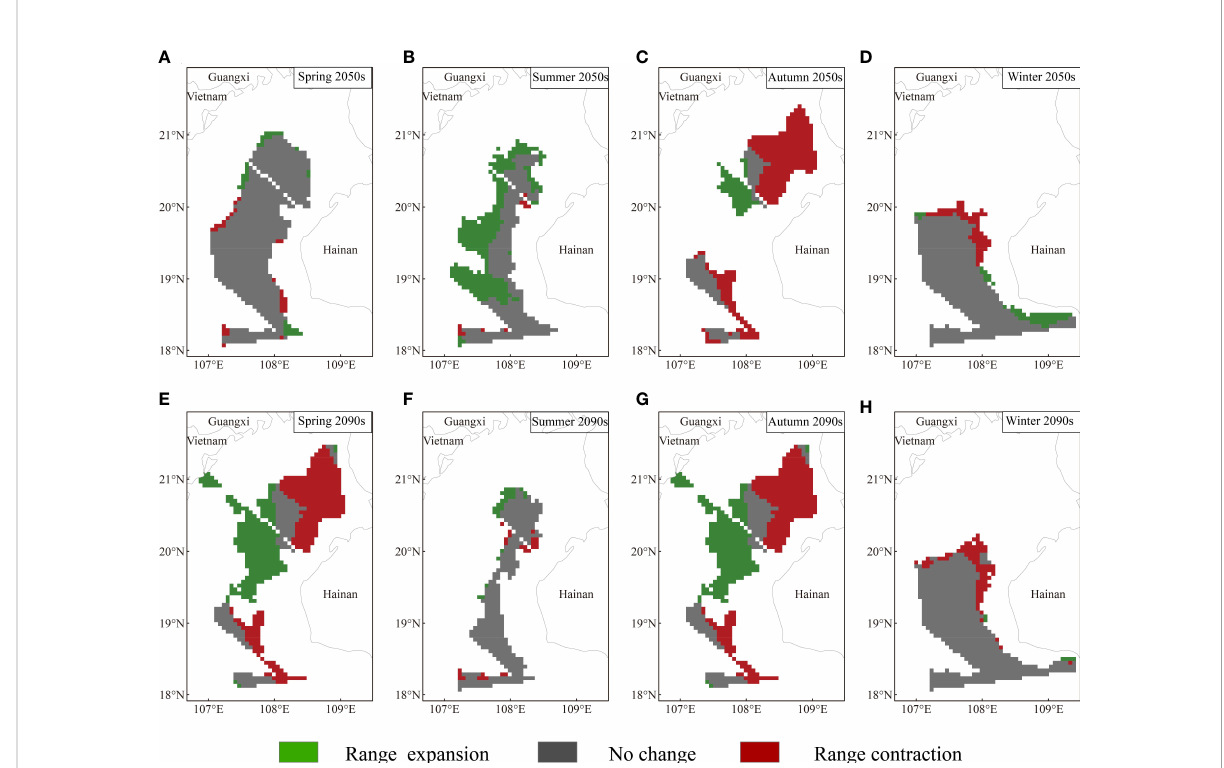
FIGURE 6 Projected range expansion or contraction for Trichiurus japonicus in the Beibu Gulf under RCP370. Area of geographic distribution changes among the species distribution models based on binary predictions for current and future (i.e., in the 2050s and 2090s) climate conditions: (A) spring 2050s; (B) summer 2050s; (C) autumn 2050s; (D) winter 2050s; (E) spring 2090s; (F) summer 2090s; (G) autumn 2090s; (H) winter